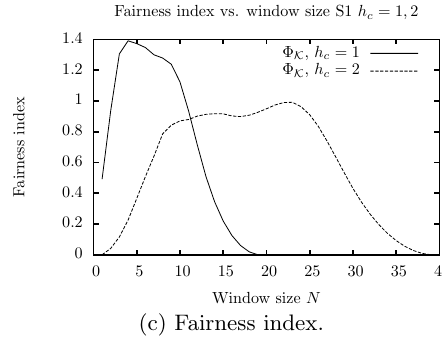
Figure 3: Performance in Scenario 2 with h c = 1 , 2